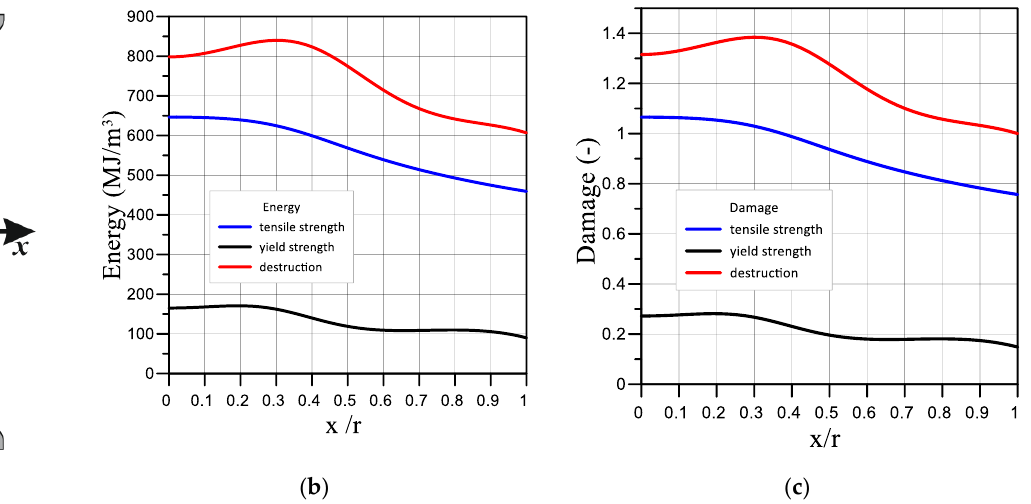
Figure 10. Diagram of the place where the results were obtained ( a ) Critical value distribution of the strain energy ( b ) and the damage parameter ( c ) in the sample under the load mode І : black curve — when the equivalent stresses reach the yield strength; blue — when the equivalent stresses reach the ultimate strength; red — at the fracture moment.